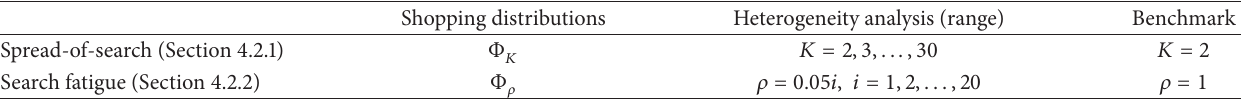
Table 3: Heterogeneous consumer’s shopping distributions in Sections 4.2.1 and 4.2.2 and their respective benchmarks. Shopping distributions Heterogeneity analysis (range) Benchmark Spread-of-search (Section 4.2.1) Φ